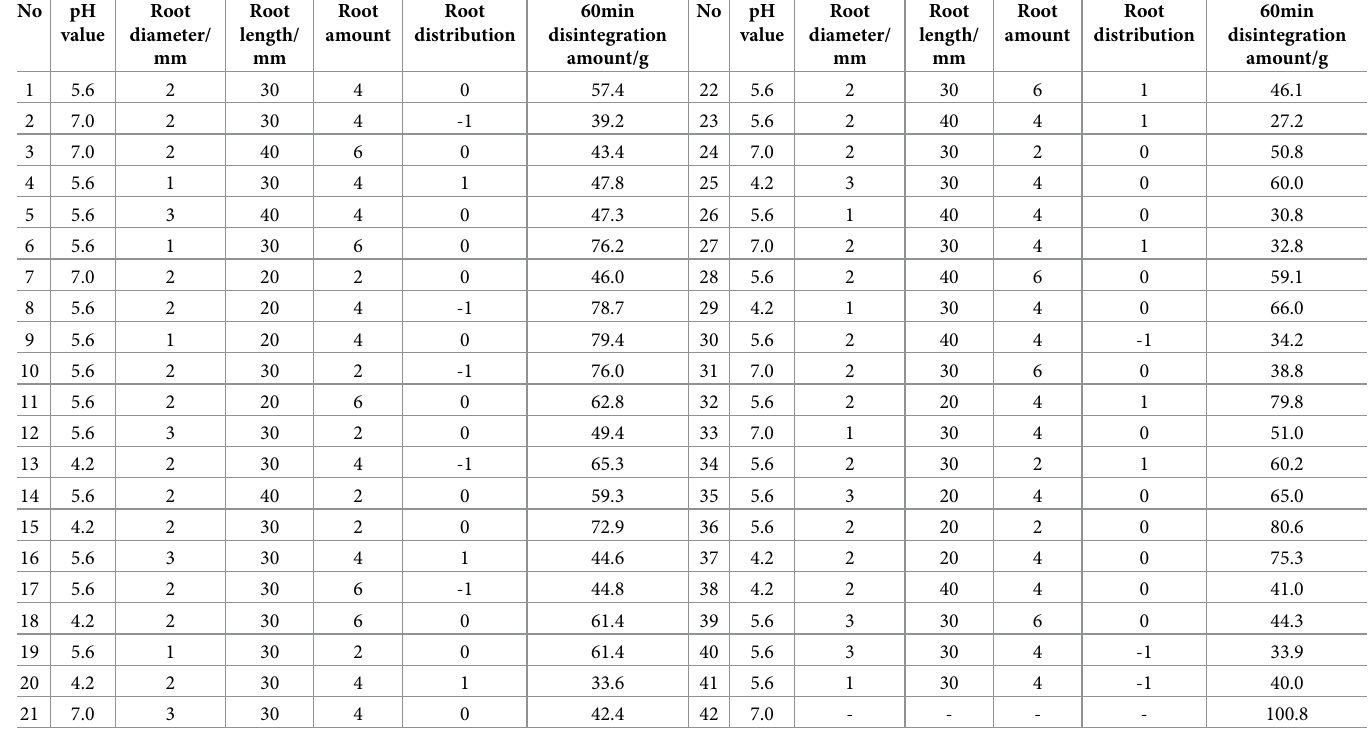
the test data and the average value of the test results is taken. The test results are shown in Table 3. The disintegrant fell to the bottom of the glass cylinder during the immersion disintegra- tion test, and the balance reading decreased as the sample disintegrated. The reading ( m Table 3. 60min disintegration test